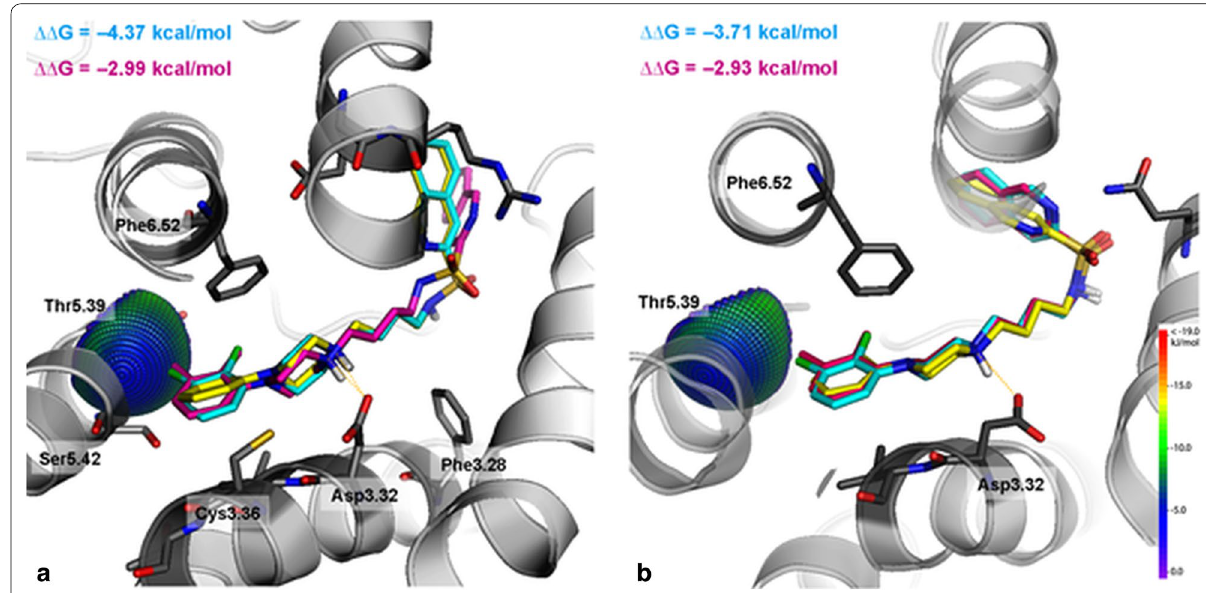
Fig. 5 Superposition of the poses of compounds 1 (yellow), 4 (magenta), and 5 (cyan) against putative halogen binding pocket interaction spheres for 5-HT 7 ( a ) and 5-HT 1A ( b ) receptors, respectively. The chlorine–oxygen theoretical interaction spheres illustrate the projected qualities of the formed ligand–receptor halogen bonds. The applied methodology is described by Wilcken et al.